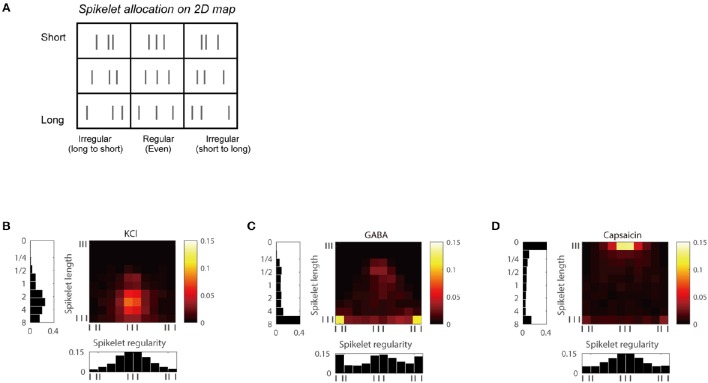
Joint distribution maps of the length and the regularity of spikelet for each chemical. (A) Simple 3 × 3 bin-2D map of spikelets based on spikelet length and regularity. (B) 2D map of KCl responses based on spikelet length (vertical axis) and regularity (horizontal axis), including histograms for each. (C,D) Responses of GABA in (C), and capsaicin in (D).